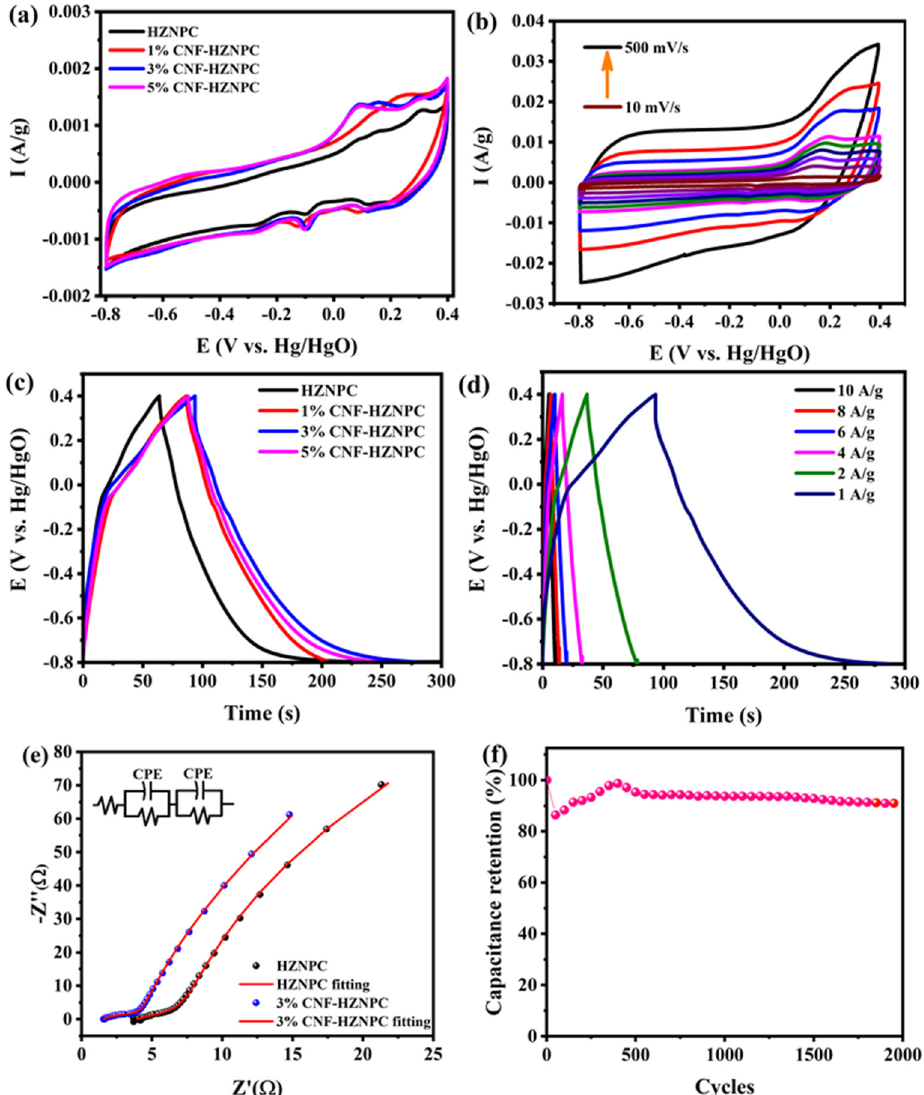
Figure 5. ( a ) CV of HZNPC and CNF-HZNPC composites, ( b ) CV of 3% CNF-HZNPC at different scan rate, ( c ) GCD of HZNPC and CNF-HZNPC composites at current density of 1 A/g, ( d ) GCD of 3% CNF-HZNPC at different current densities, ( e ) EIS of HZNPC and 3% CNF-HZNPC, ( f ) cycling performance of 3% CNF-HZNPC at 10 A/g. The GCD curves of all samples were obtained at a current density of 1 A/g in the potential range of − 0.8 to +0.4 V in 1 M KOH solution (Figure 5c). The symmetrical